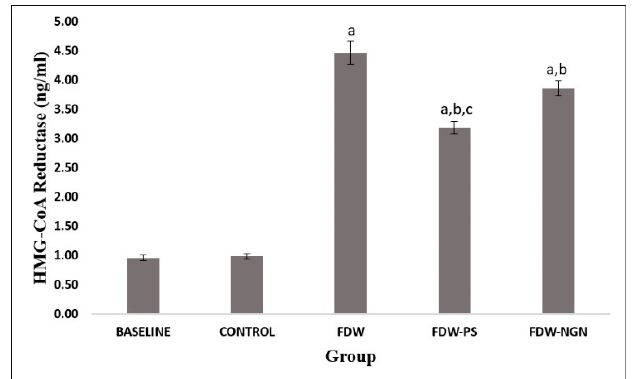
Figure 4. HMG-CoA reductase levels of all groups over 12 weeks. Values are mean ± SD and n = 8 for each group. Superscript letters indicate significantly different. a p < 0.05 compared to the control group. b p < 0.05 compared to the FDW group. c p < 0.05 compared to the FDW-NGN group. FDW: Olive oil + 20% fructose; FDW-PS: PS + 20% fructose; FDW-NGN: Naringin + 20% fructose.